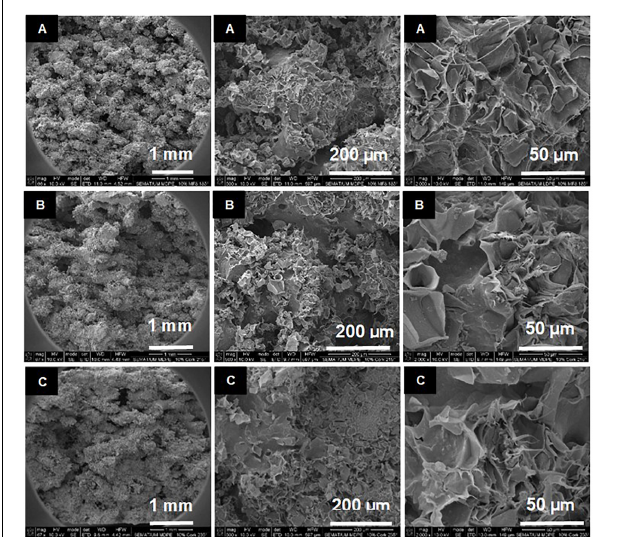
FIGURE 8 | Morphology of the impact–fracture surface of MDPE/10% cork produced at (A) 201 ◦ C, (B) 227 ◦ C, and (C) 238 ◦ C.